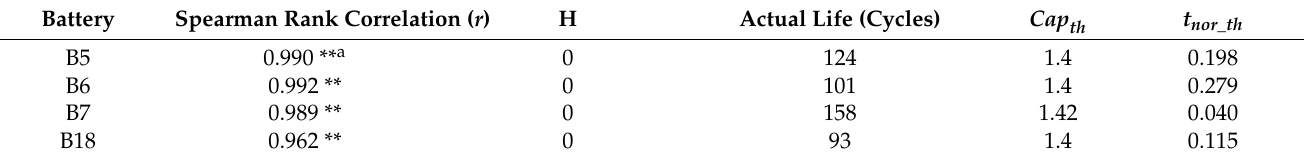
Table 2. The correlation analysis and the failure thresholds